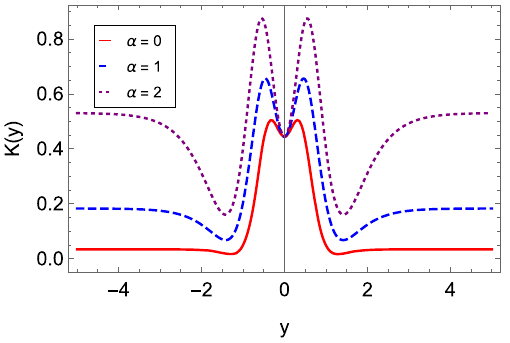
Fig. 9 Numerical solutions for the Kretschmann scalar K ( y ) from Eq. (46) with ψ 0 = − 1, φ 0 = U 0 = k = 1 for different values of